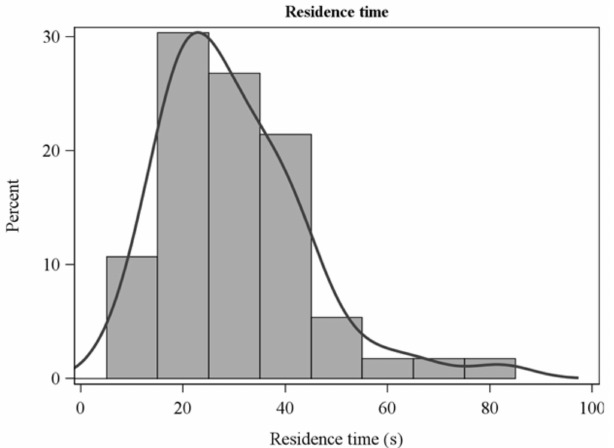
Figure 2. Frequency distribution of residence times defined by a 3-s moving-averaged temperature rise greater than 50 ◦ C above